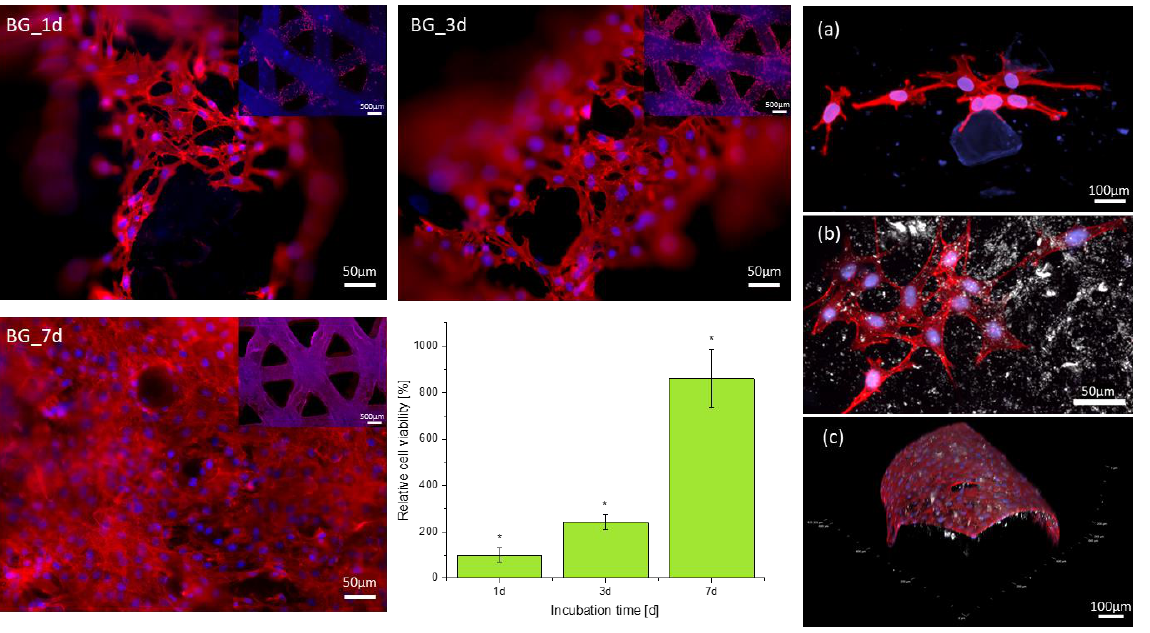
Figure 11. Fluorescence images of MC3T3-E1 cells directly seeded onto the BG–alginate composite scaffold surface. Images taken 1 d, 3 d and 7 d post cell-seeding. Cell viability test (WST-8) after 1d, 3d, and 7d post cell-seeding in relation to the cell viability after 1d post cell-seeding, set as reference ( bottom middle ). Confocal fluorescence microscopy images of scaffolds 1 d ( a , b ) and 7 d ( c ) post cell-seeding. MC3T3-E1 cells are observed with stained actin filament (red) and cell nuclei (blue). Statistical analysis using one-way ANOVA indicated a significant difference (* p < 0.05) for all time points of culture.